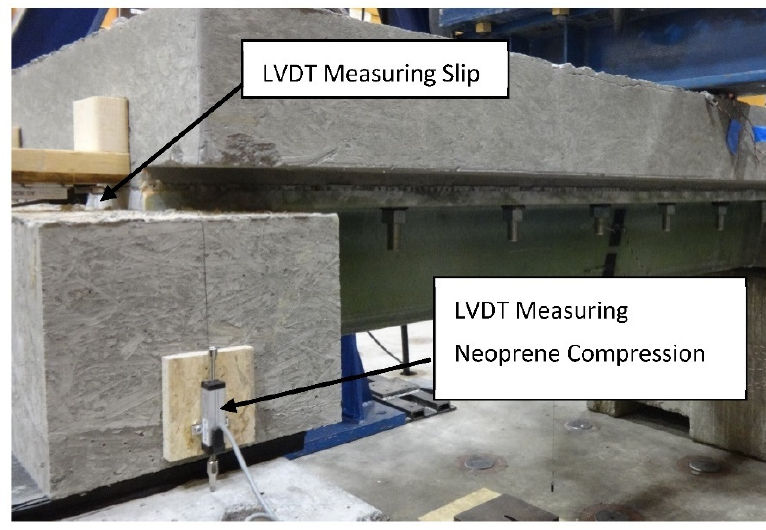
Figure 10. Short Beam Specimen Instrumentation at Support.